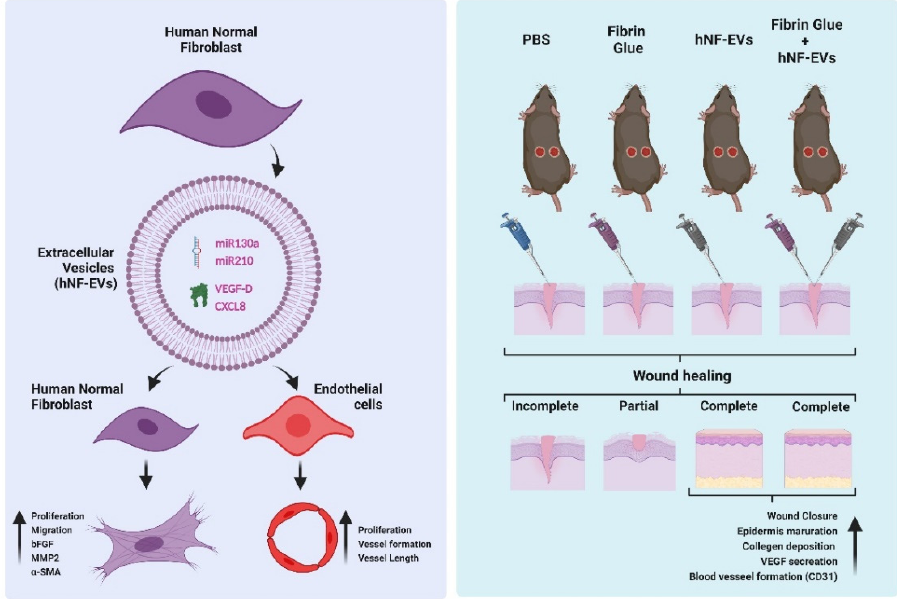
Figure 10. The schematic representation of hNF-EV induced promotion of fibrogenesis and angiogenesis in vitro and accelerated wound healing in in vivo, Created with BioRender.com (accessed on 27 May 2022).